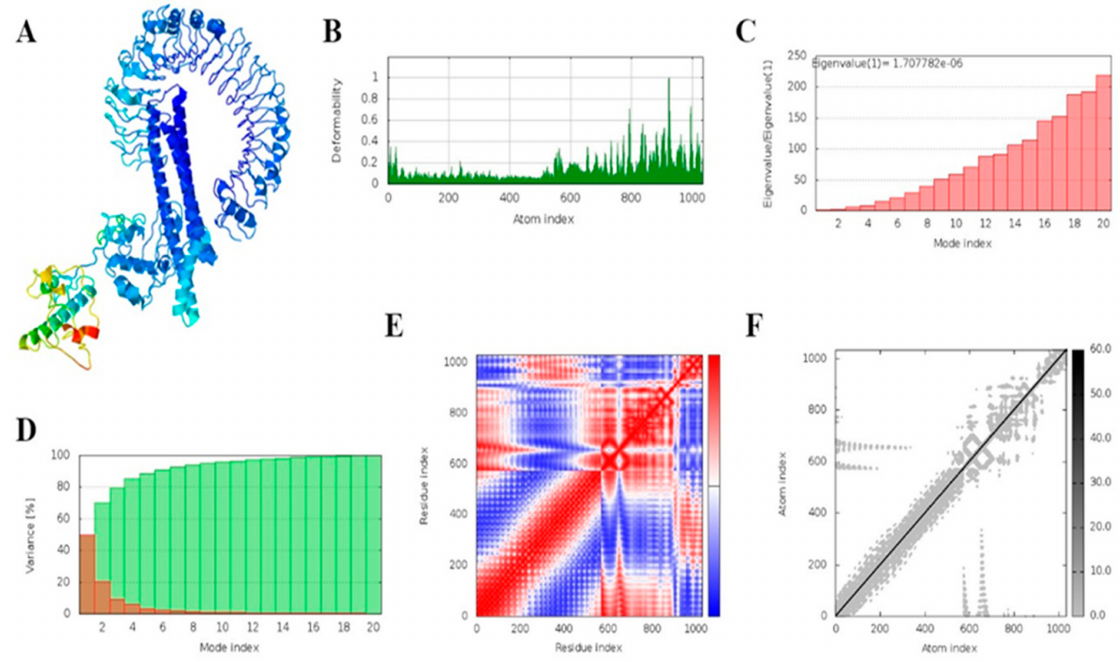
Figure 13. Outcomes of MD simulations of TLR-4 and the designed Vaccine construct. ( A ) NMA mobility, ( B ) deformability plot, ( C ) eigenvalue plot, ( D ) variability plot (individual variances are brown, while cumulative variances are green), ( E ) covariance map [correlated (red), uncorrelated (white), or anti-correlated (blue) motions], ( F ) elastic network (darker grey regions indicate stiffer regions) of the